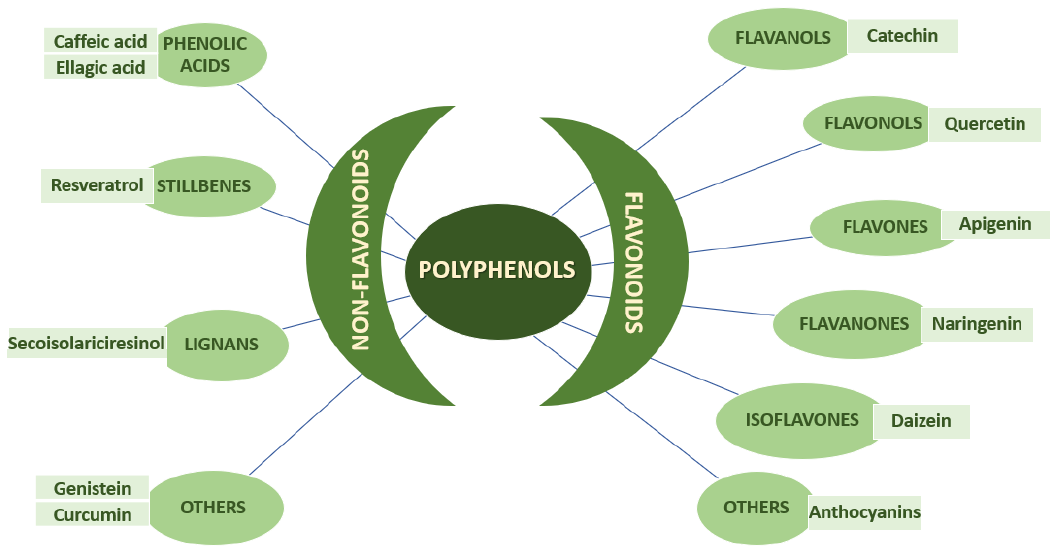
Figure 3. Classification of polyphenols (adapted by [105]).